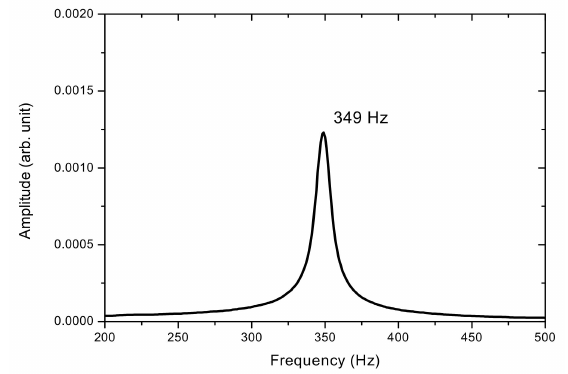
Figure 9. Power spectrum density for the non-moving vibrating string.